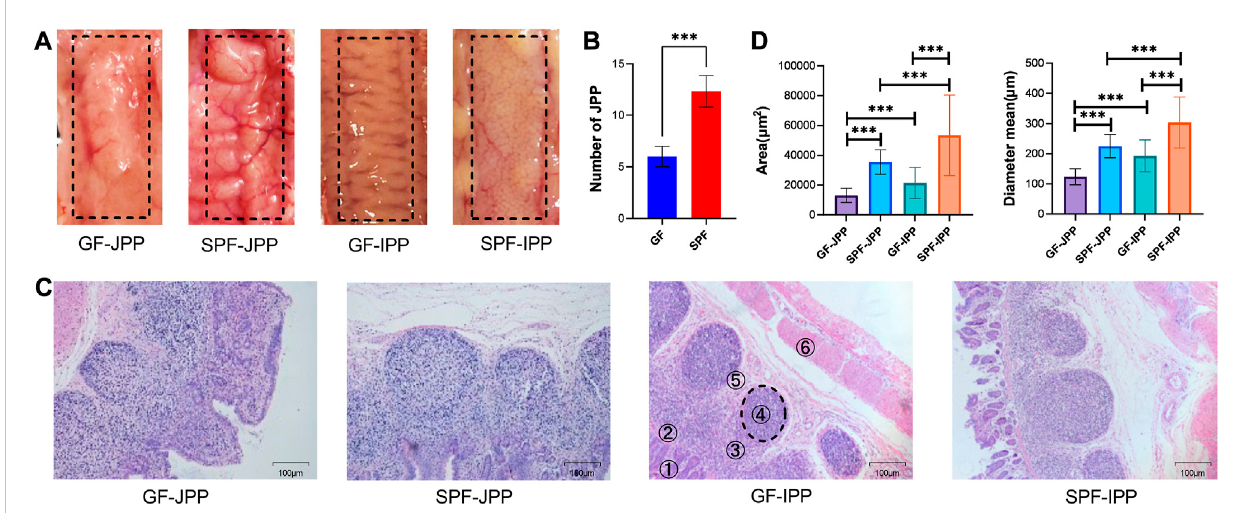
FIGURE 2 Anatomical and histological characteristics of PPs. (A) The anatomical characteristics of PPs observed by the naked eye. (B) Quantity statistics of JPPs. (C) The histological characteristics of PPs (1: villus lamina propria; 2: epithelial layer; 3: subepithelial dome area; 4: follicular area; 5: interfollicular area and 6: muscle layer); scale bar: 100 μ m. (D) Quantitative analysis of the area and diameter of GC in PPs. Means ± SDs are presented for each group. n = 3. *** p <